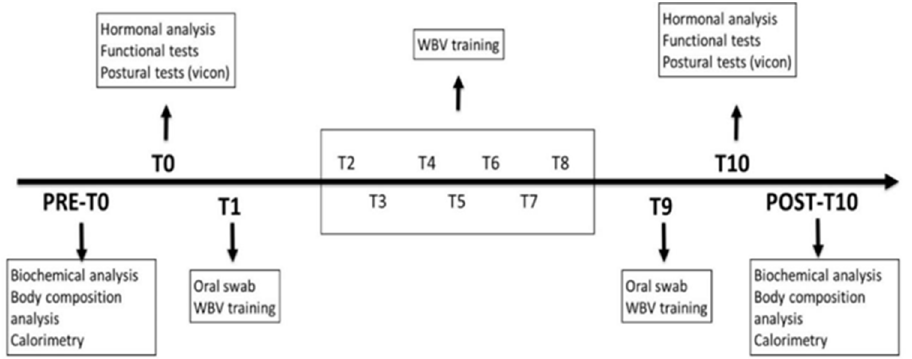
Figure 1. Timeline of the study protocol.